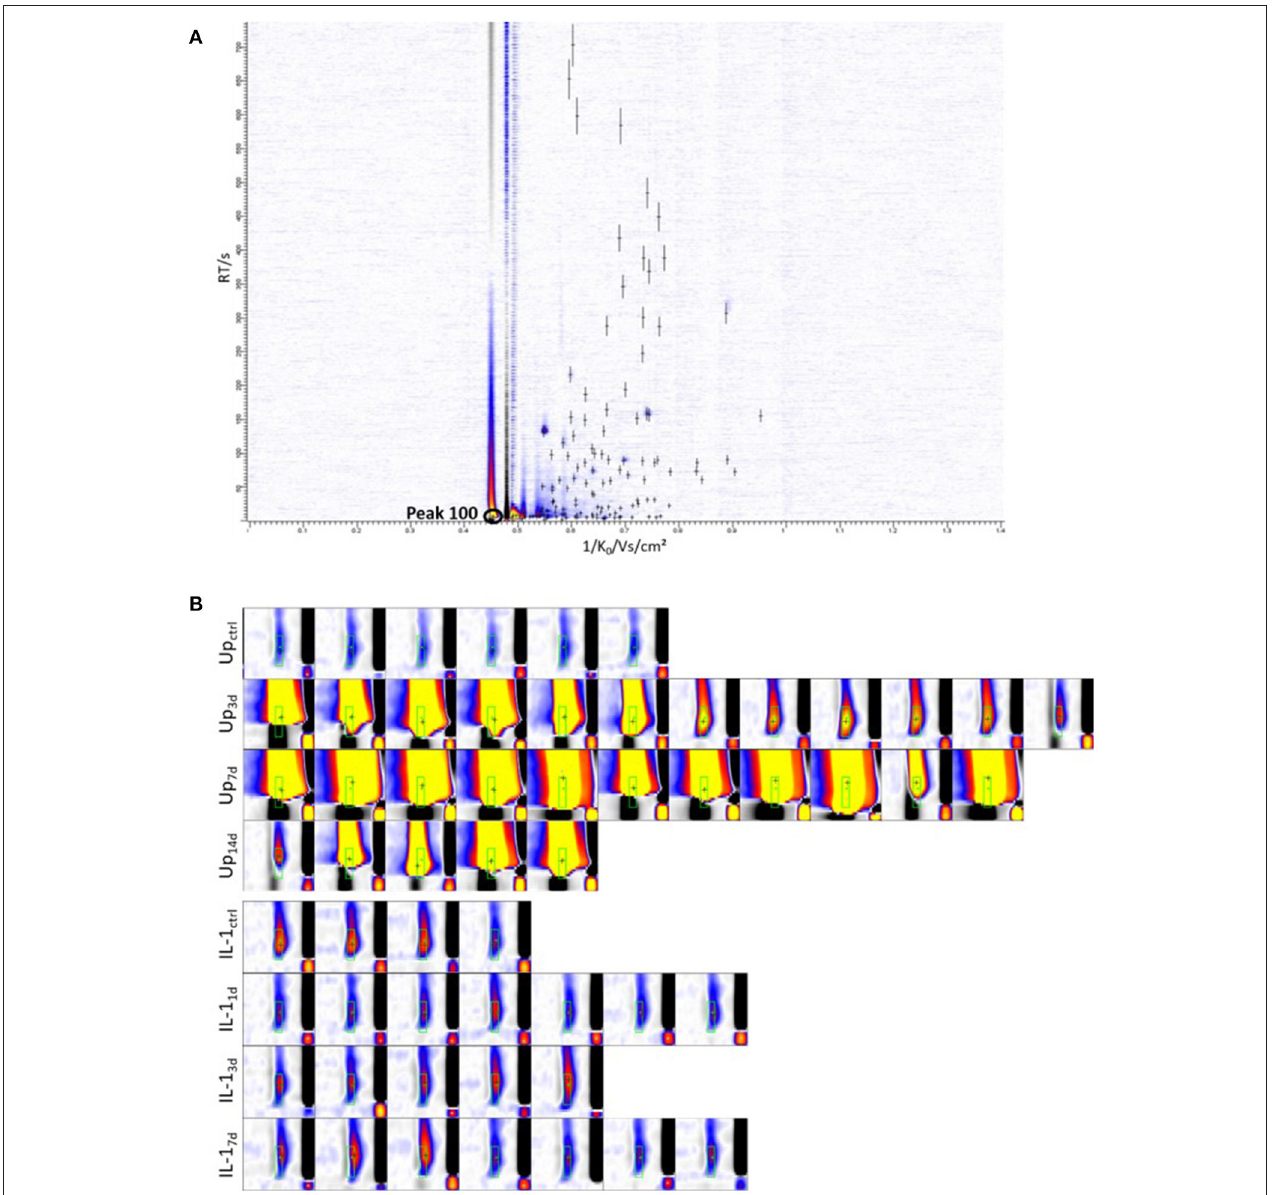
FIGURE 2 | Representative chromatogram and intensity distribution of peak 100 (2-methylpentane). (A) All 127 peaks identified in amniotic fluid are indicated with crosses. The y-axis of the heat map represent the retention time and x-axis represent 1/K0, a transformation of the drift time. The colors display the signal intensities with increasing values from white over blue and red to yellow. (B) Shown are the cutouts of MCC/IMS-Chromatograms of peak 100 for every single measurement. White = no signal, blue = low signal, red = medium signal, yellow = high signal, black = reactant ion peak (RIP), x- axis = inverse mobility 1/K 0 /Vs/cm 2 . Up , Ureaplasma parvum ; IL-1, Interleukin-1 α